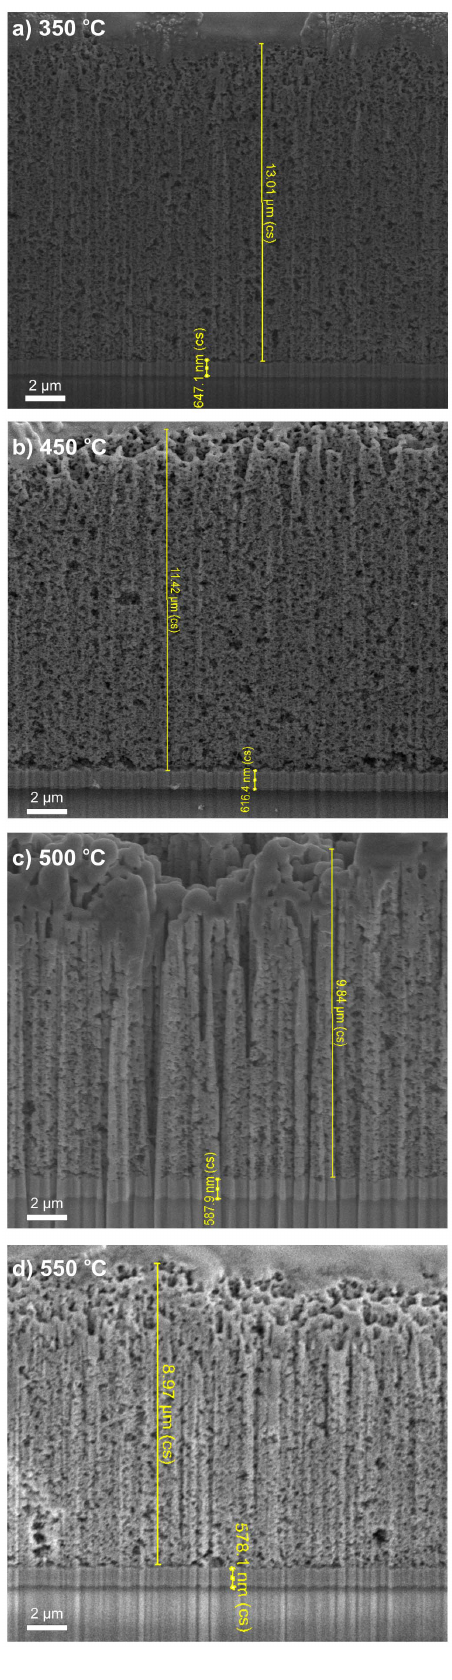
Figure 3. FIB imaging measurements of TiO 2 and SnO 2 :F cross- sections after sintering at a) 350 6 C; b) 450 6 C; c) 500 6 C; d) 550 6